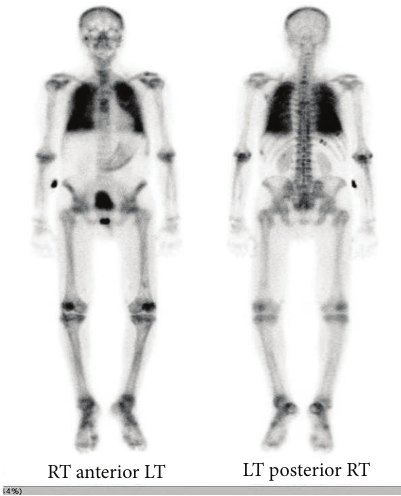
Figure 3: Technetium 99 bone scan, which revealed diffuse activity in the lung with significant lighting up of pulmonary